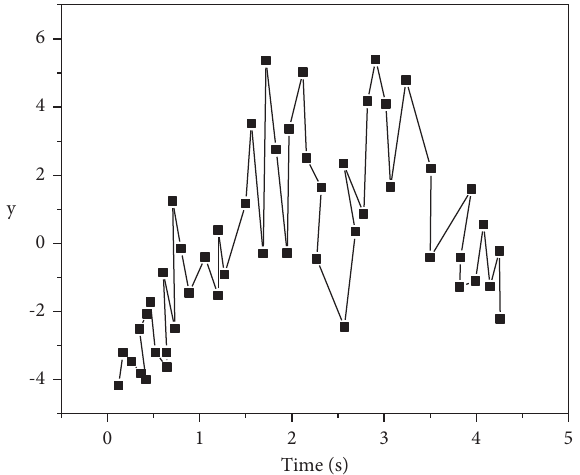
Figure 2: Time-delay distribution sequence of robot electrical fault